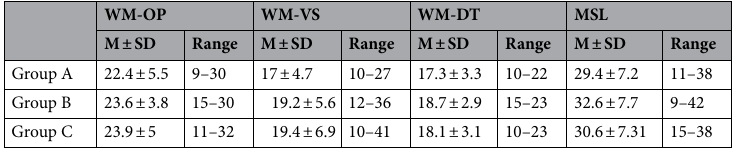
Table 2. Mean (M), standard deviation (SD) and range of reached levels for WM and MSL (MOST) at the end of the training. OP, operation n-back task; VS, visuospatial task; DT, dual n-back task.